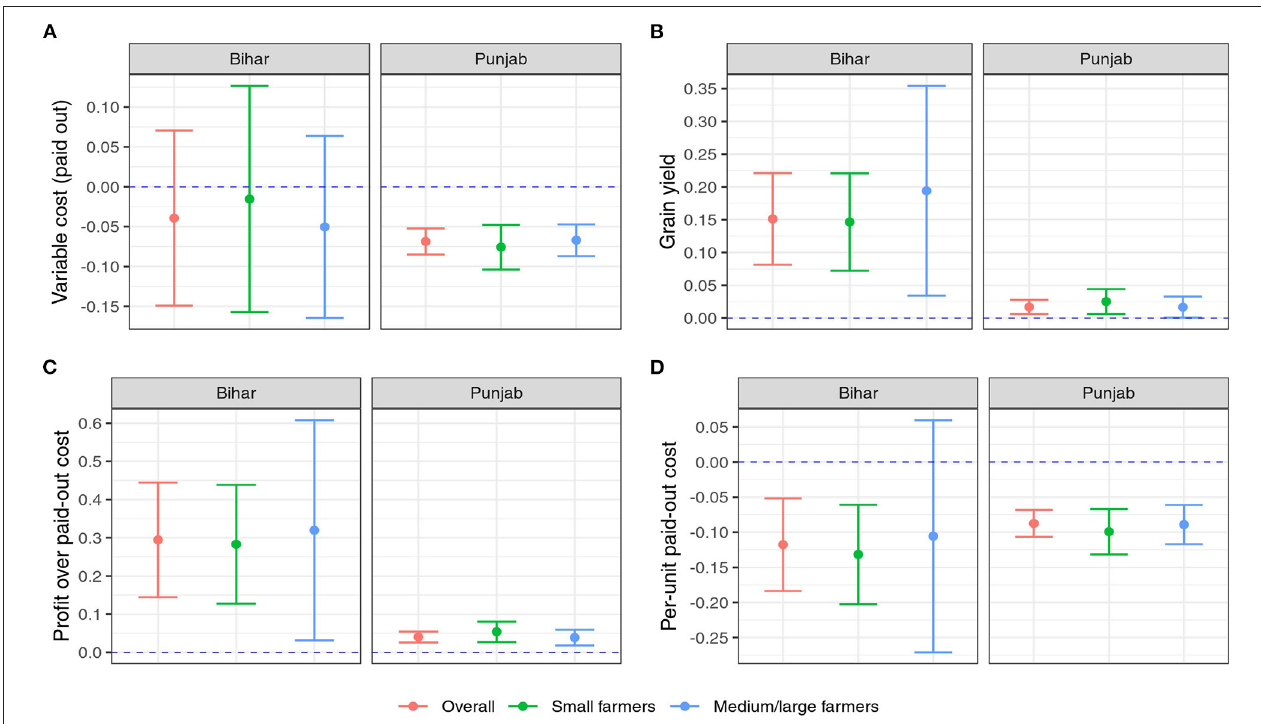
FIGURE 4 | Plot level economic effects (%) of ZT adoption by wheat farmers in Punjab and Bihar. Figures show percentage change over non-adopters. The absolute effects are provided in Supplementary Materials S5 .